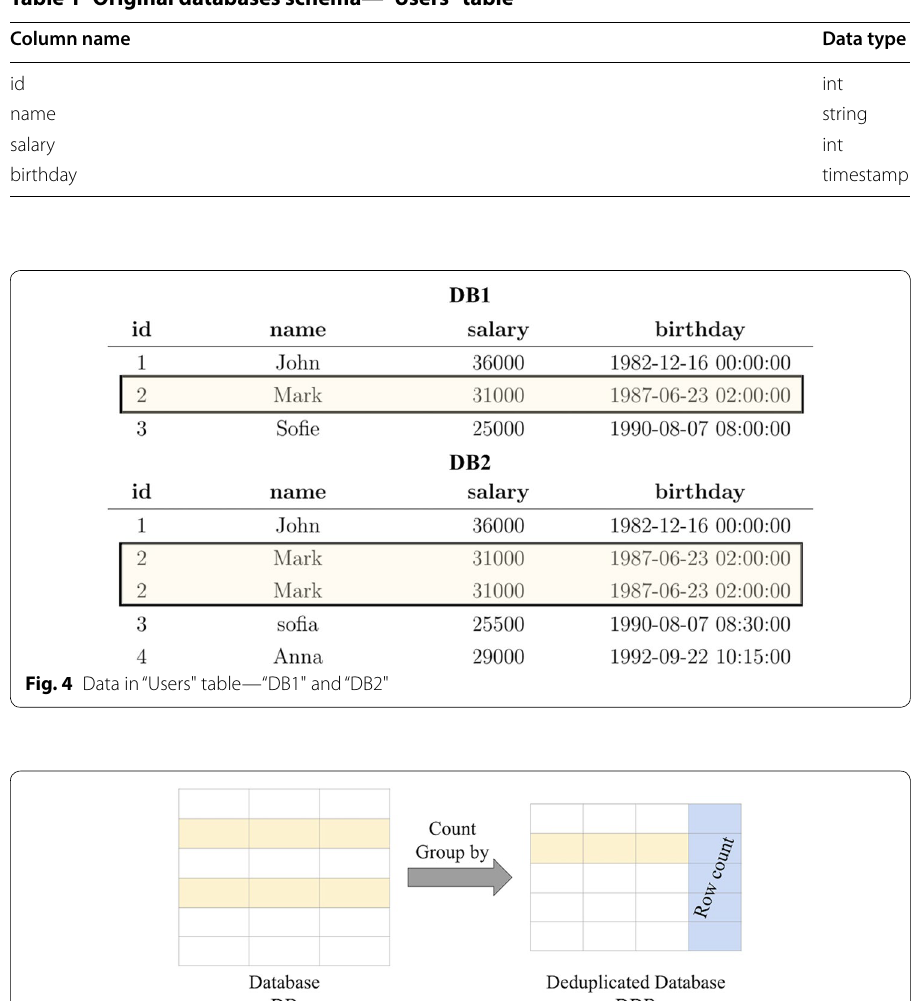
Table 1 Original databases schema—“Users” table